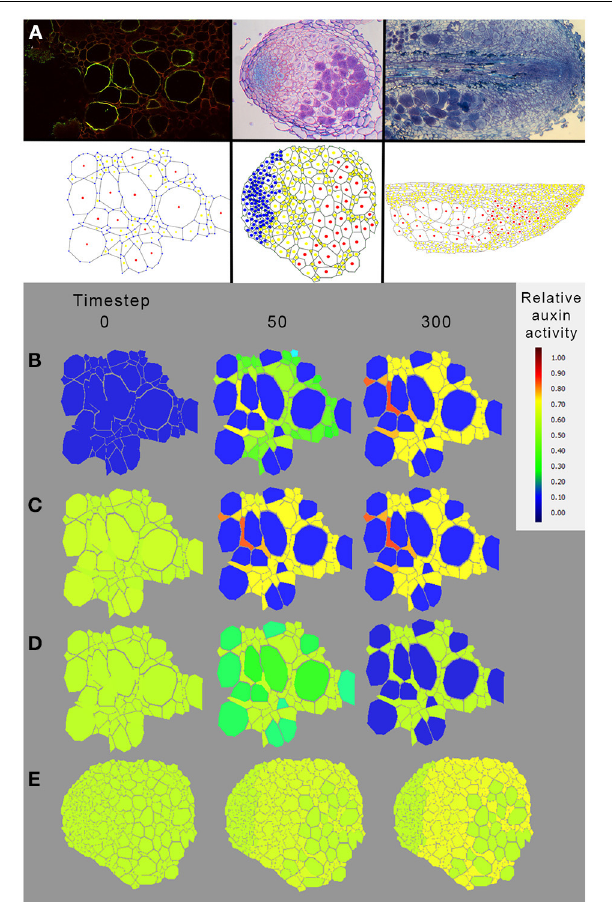
FIGURE 7 | Modeling auxin fluxes in D. trinervis nodules. (A) Example of digitization of nodule tissue. Images of nodule tissue autofluorescence (top panel) were used as a base for manual digitization of the geometry in a virtual representation of the nodule (Perrine-Walker et al., 2010). Information regarding the infection of the cells was added in the virtual tissue (infected cells are denoted in red, uninfected cells in yellow and meristematic cells in blue). (B–E) Distribution of auxin in a virtual nodule with meristematic cells expressing DtAUX1 and infected cells expressing a PIN1-like auxin efflux carrier. Auxin flux simulations were conducted with either no initial auxin and basal auxin production throughout the tissue (B ), basal initial auxin level throughout the tissue (C) , or an auxin source located within the Frankia compartment (to simulate auxin production by Frankia , D , E ). In all cases, auxin was predicted to accumulate in non-infected cells of D. trinervis actinorhizal nodules rather than in infected and meristematic cells. Exploration of the model parameter space did not reveal a parameter configuration for which the biological auxin accumulation could be reproduced by the model based on DtAUX1 and DtPIN1 localization (data not shown). This suggests that the mechanisms leading to auxin accumulation in those cells do not rely exclusively on D. trinervis PIN1-like and